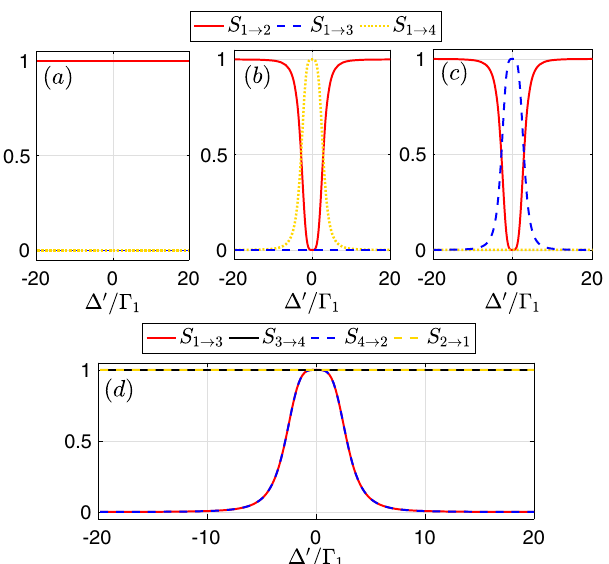
Fig. 8 Targeted routing and circulating scheme with a three-level ∇ -type giant-atom system. Scattering probabilities versus the detuning Δ 0 with different Rabi frequencies of the external coherent fi eld Ω and coupling phase differences θ and θ 0 a Ω = 0, θ = π /2; b Ω = 2 Γ 1 , θ = π /2, θ 0 ¼ π = 2; c and d Ω = 2 Γ 1 , θ = π /2, θ 0 ¼ 3 π = 2. Other parameters: atomic dissipation rates γ ¼ γ ¼ 0, the ratio of two atomic emission rates into different e 1 e 2 waveguides Γ 2 / Γ 1 = 1, and accumulated phases of the photon traveling in waveguides W a and W b ϕ a 0 = ϕ b 0 = π